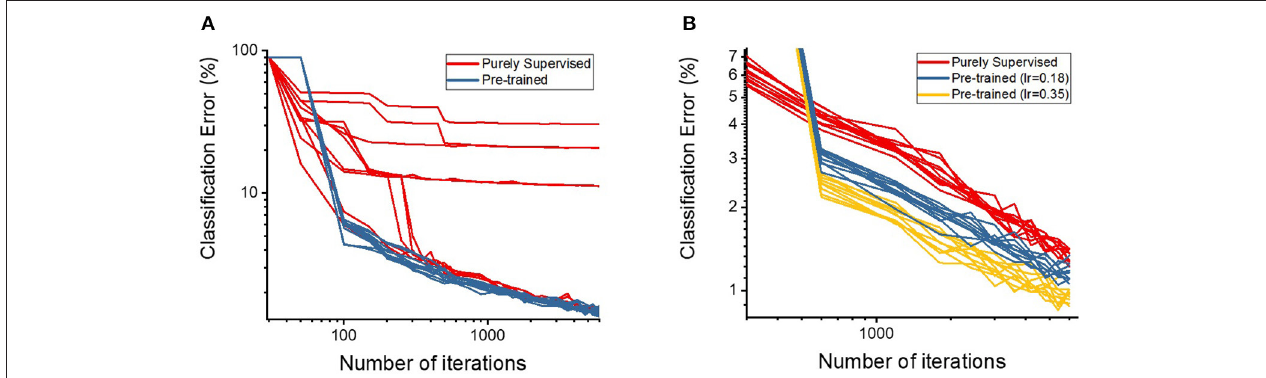
FIGURE 4 | The classification accuracies (in log scale) on (A) shallow and (B) deep multi-layer convolutional spiking neural networks of pre-trained and supervised model starting from different states of randomly initialized synaptic weights.